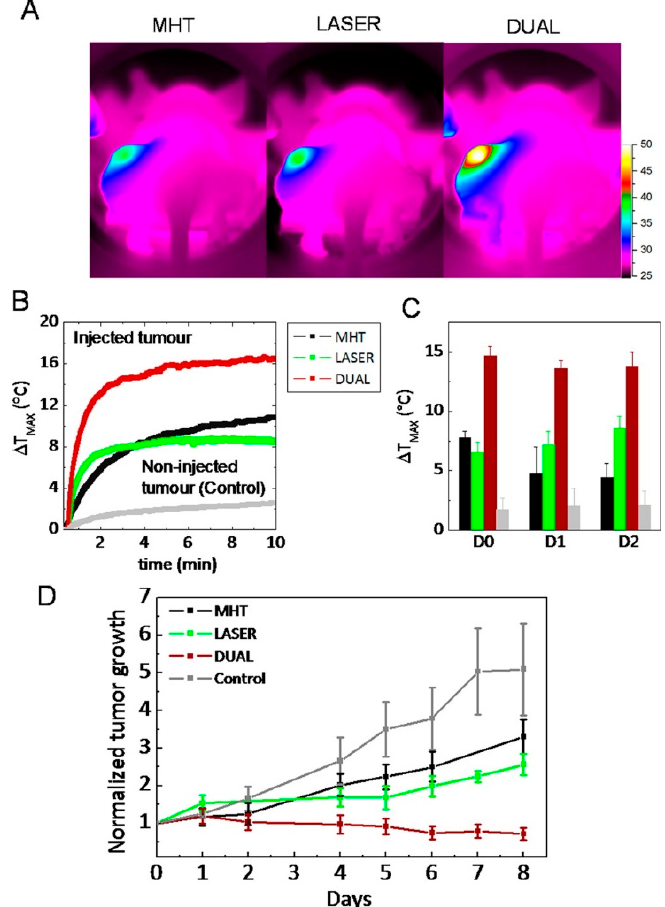
Figure 8. In vivo heat therapy. ( A ) Thermal images obtained with the IR camera in mice, after